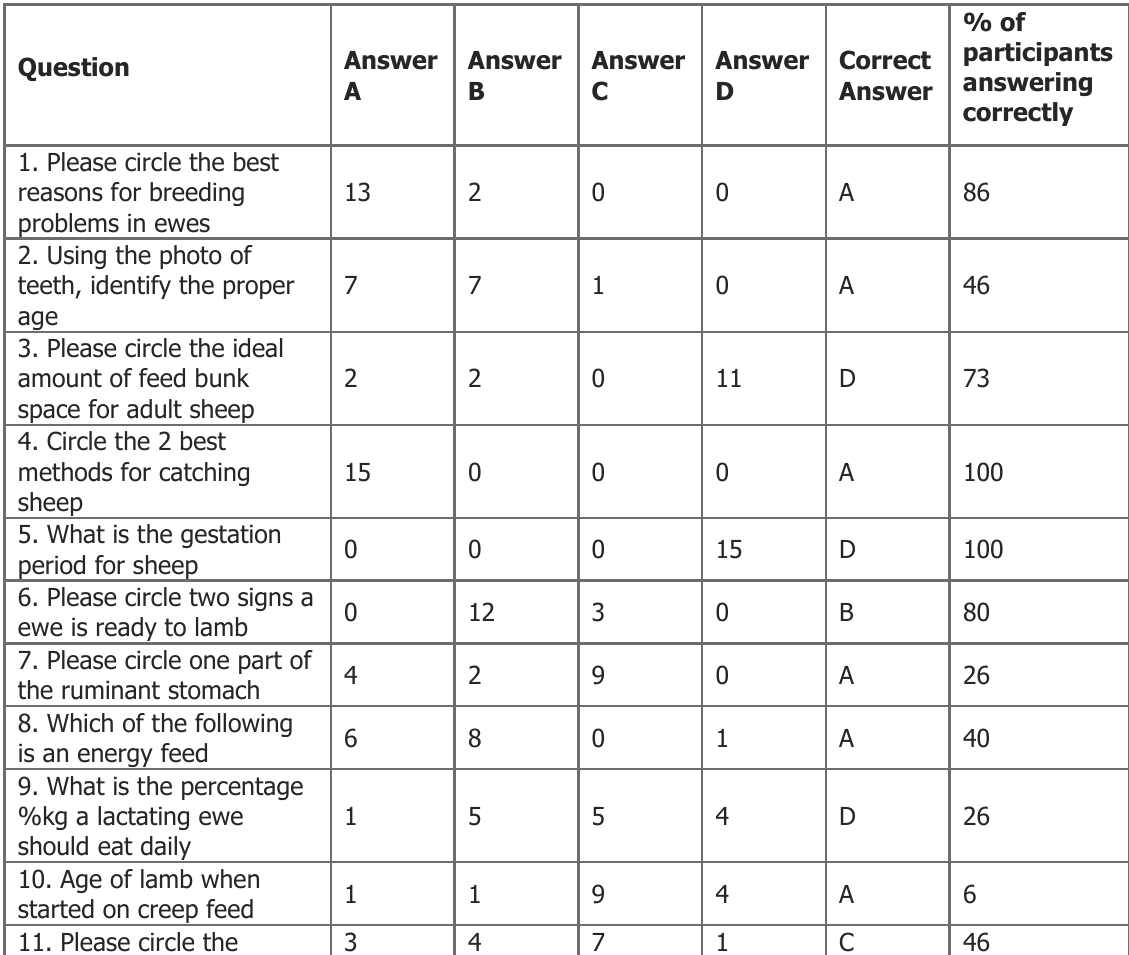
Iraqi 4-H Leader Post-Test Evaluation Results